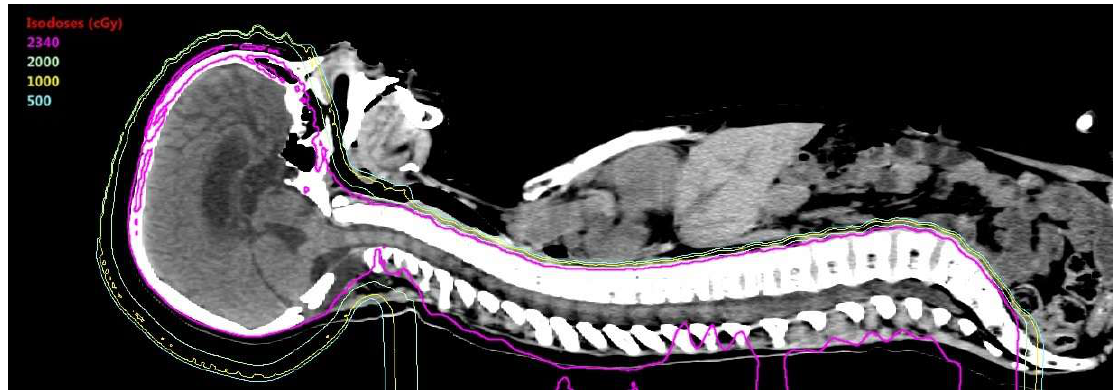
Figure 2. Proton beam therapy CSI. Representative mid-sagittal image of an 11-year-old male patient status post gross total resection for average-risk posterior-fossa medulloblastoma being planned for adjuvant radiotherapy (RT) including craniospinal irradiation (CSI). Shown here are isodose lines (colored lines) for the radiation treatment plan for the CSI component of this patient’s adjuvant RT. CSI fields cover the complete brain and spinal cord to the termination of the thecal sac in the sacrum. The 100% isodose line (23.4Gy[RBE]) covers the entire target volume as shown in this image. As this patient is being treated with PBT, the posterior-positioned spinal fields have their terminal Bragg peak at the anterior-most portion of the vertebral bodies. Therefore, there is no exit dose anterior to the vertebrae, as shown with the isodose lines, including the low-dose 5Gy[RBE] isodose line (cyan). No dose is seen treating anterior structures such as the heart, liver, thyroid, gastrointestinal organs, or other anterior structures seen in this representative sagittal slice.